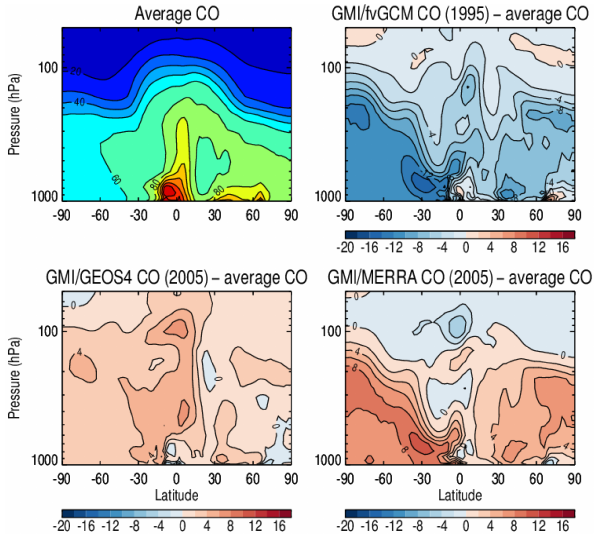
Figure 5. Same as Fig. 2 but for zonal mean CO mixing ra- tios (ppbv).